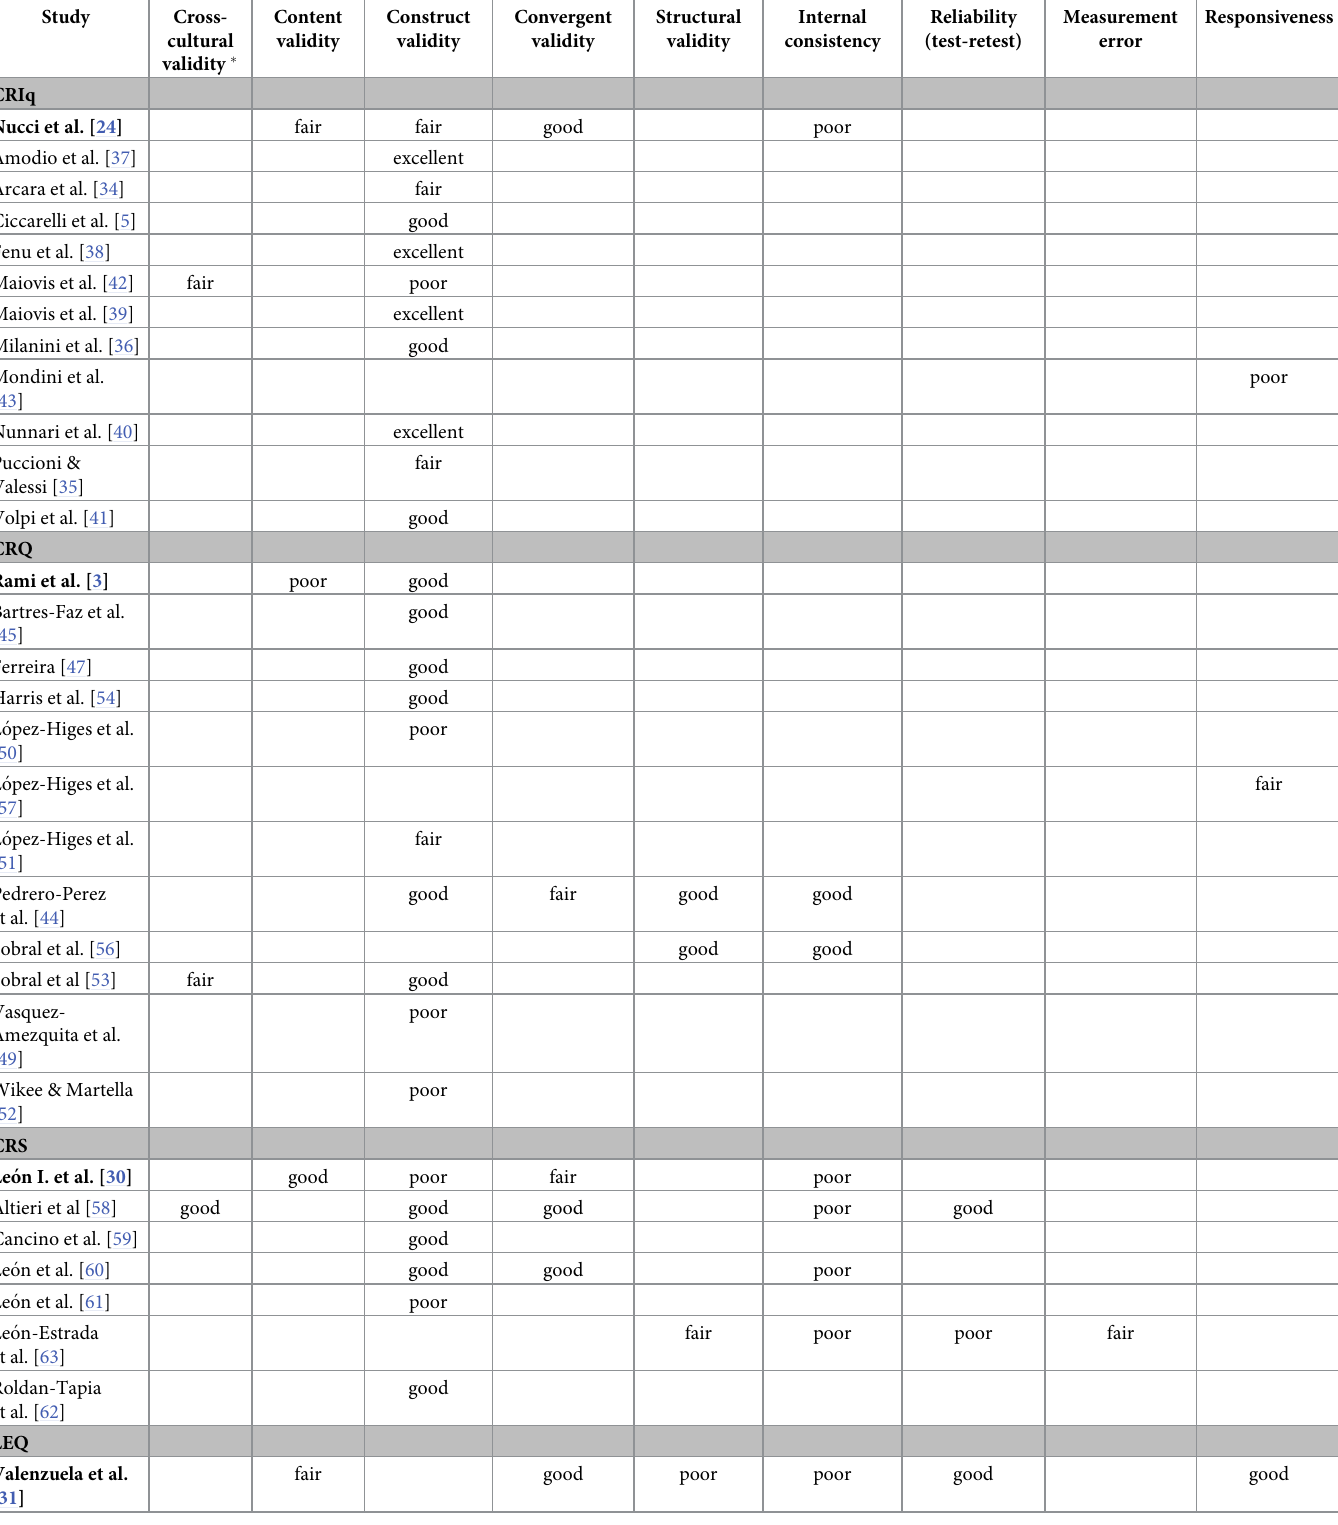
Table 4. Risk of bias in each study on measurements aspects by questionnaire (the terms denote the quality of measurement, not the result of the